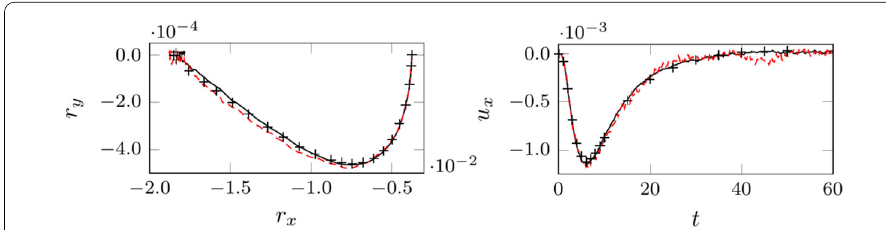
Fig. 9 Interaction of a floating rigid circular disk with a fixed rigid circular disk: trajectory and horizontal velocity u x of the center of the floating circular disk in the channel computed with the proposed formulation and an initial particle spacing of (cid:10) x = 2 . 0 × 10 − 4 (red dashed line) and (cid:10) x = 1 . 0 × 10 − 4 (black solid line) compared to the reference solution [8]